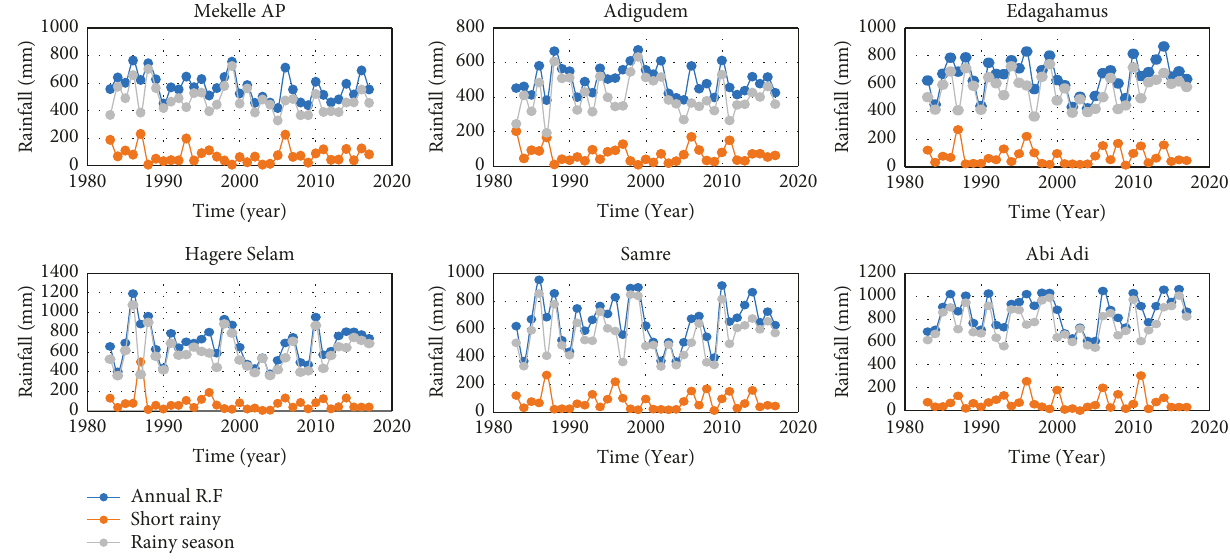
Figure 4: Seasonal temporal variability of rainfall (mm) in stations of 35 years of observation.